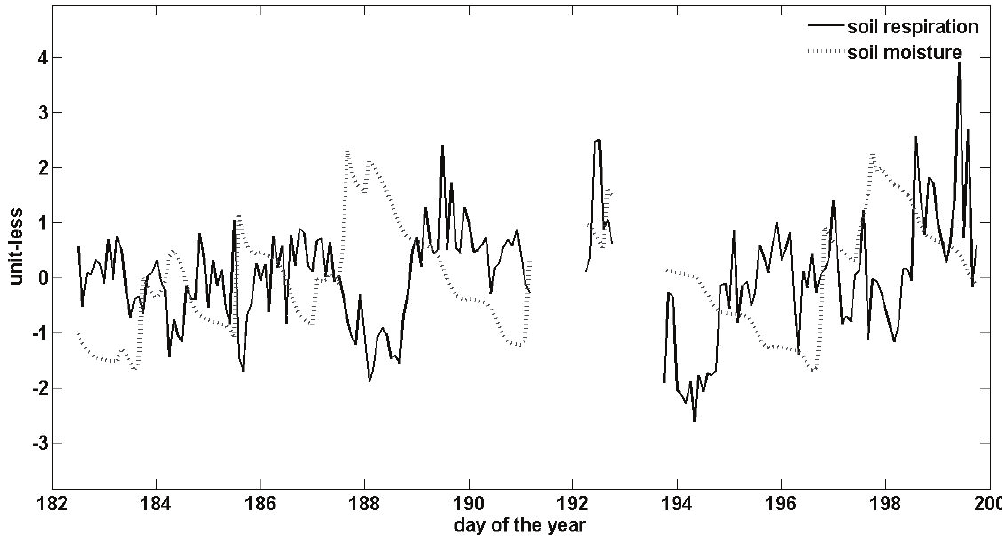
Figure 3. Plot of soil moisture and soil respiration for one of the eight field campaigns (18-days, June 30-July 18, 2008). Soil respiration declined following large rainfall events and the subsequent increase in soil moisture.